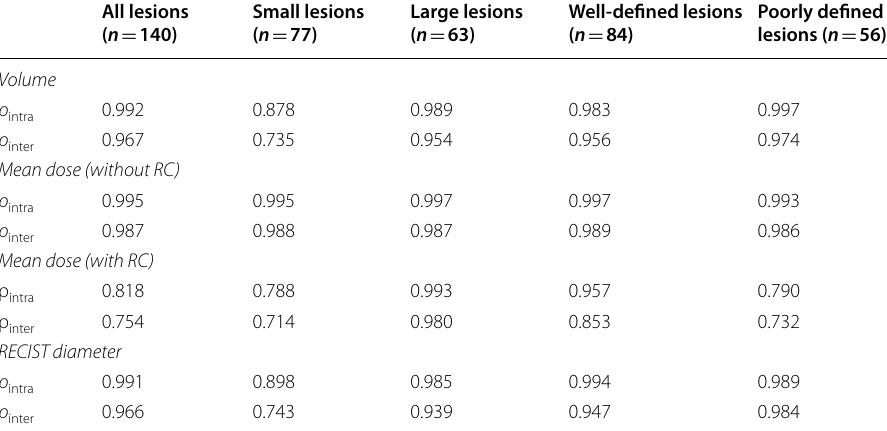
ρ intra intra-observer reliability coefficient; ρ inter =